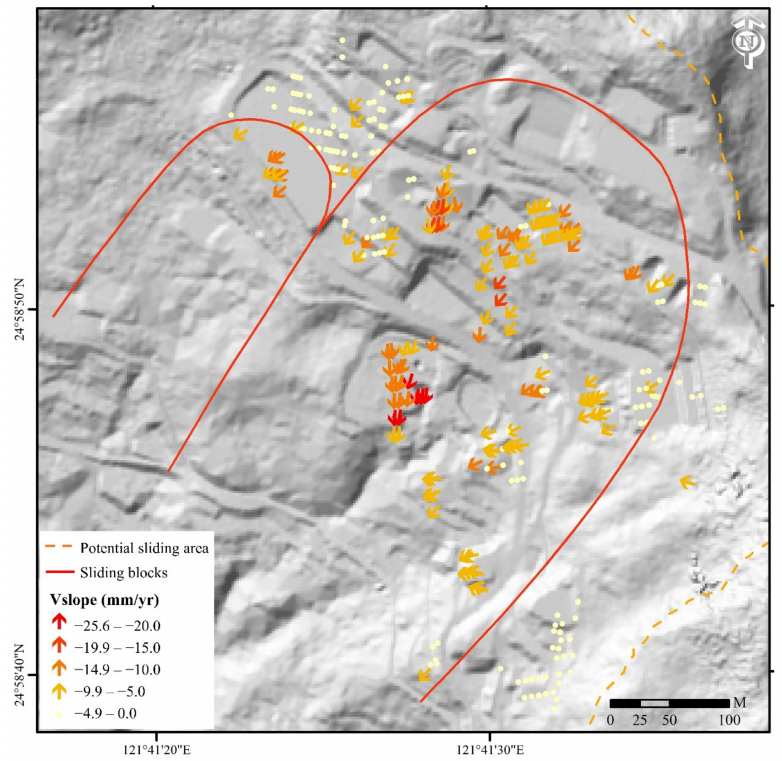
Figure 5. The projection of both ascending and descending LOS velocities along the downslope direc- tion. The slow-moving phenomenon was significant, and the maximum displacement velocity along the downslope direction was approximately 25 mm/yr. The arrows indicate that the displacement was along the downslope direction. The background topography is shown by shaded relief imagery produced from a 2 m